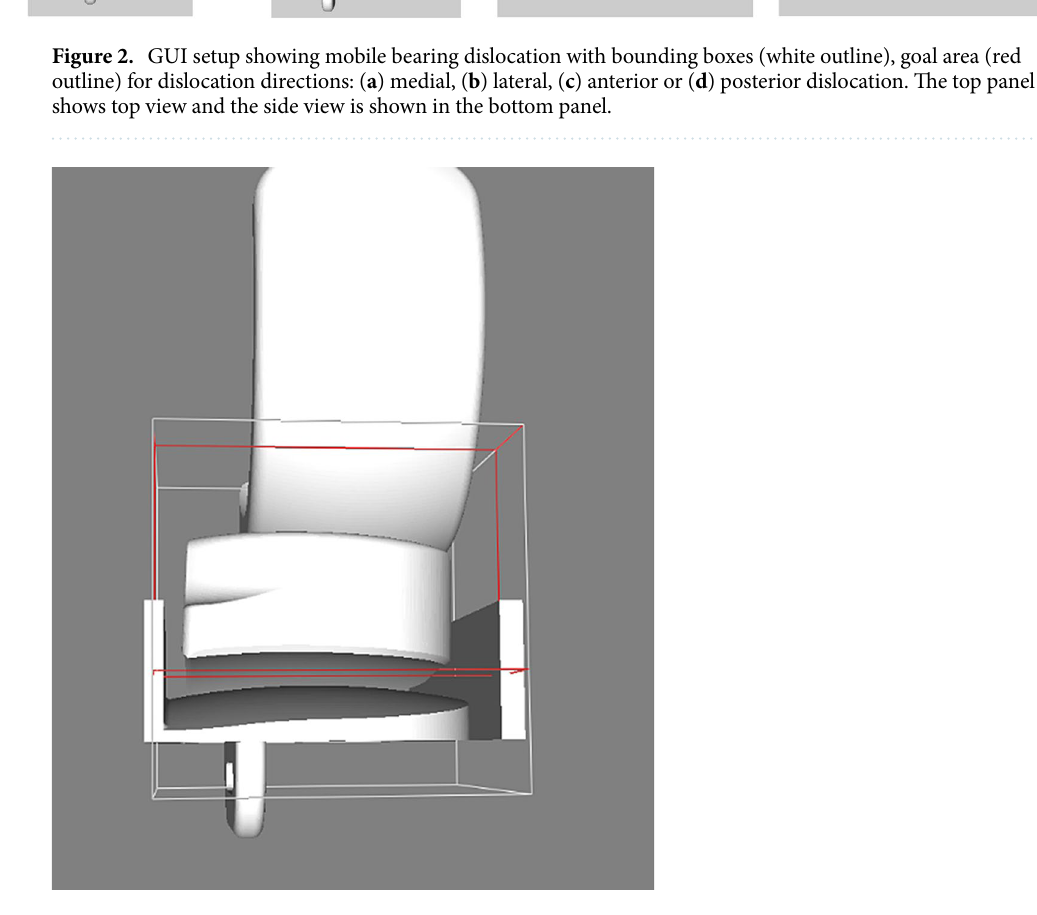
Figure 3. Additional wall added laterally for anterior/posterior dislocation